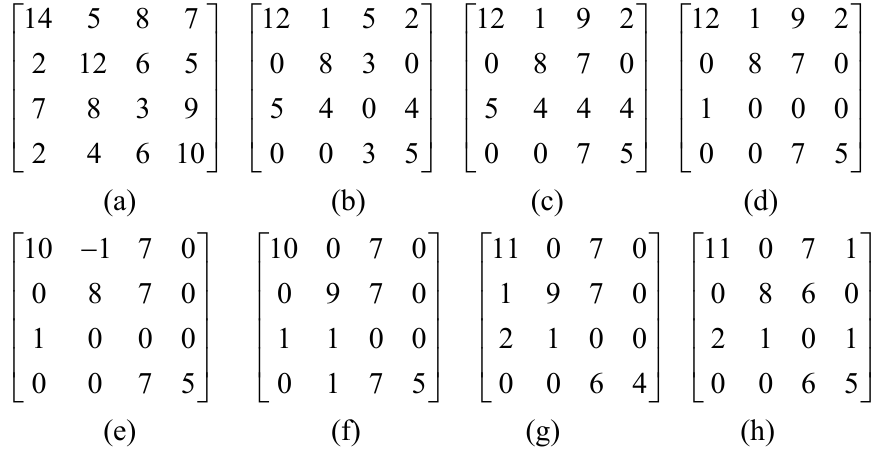
Figure 2. A step-by-step example of the initialization process. ( a ) Example cost matrix; ( b ) After column reduction; ( c ) After reduction transfer of row 3; ( d ) After row reduction to row 3; ( e ) After reduce 2 in row 1; ( f ) After inverse column reduction on column 2; ( g ) After augmenting row reduction on row 4 ; ( h ) After augmenting row reduction on row 2.